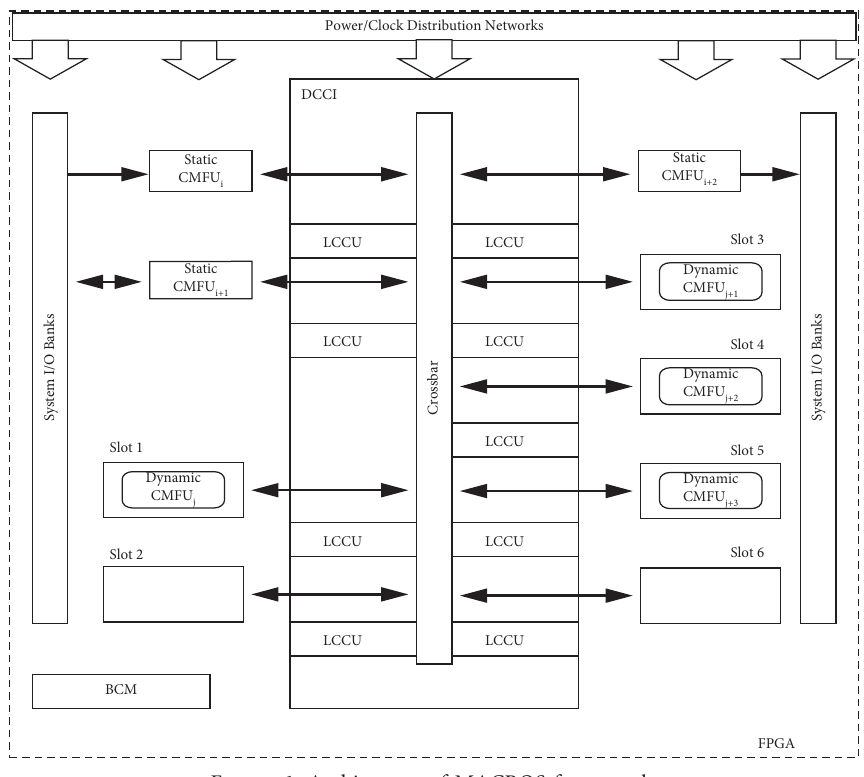
Figure 1: Architecture of MACROS